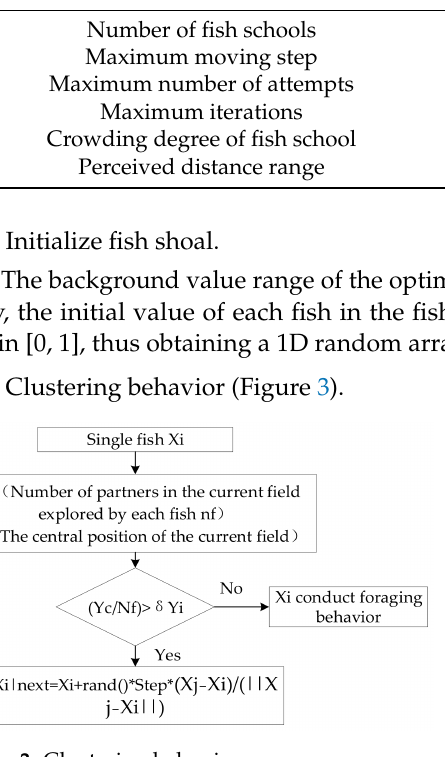
Figure 3. Clustering